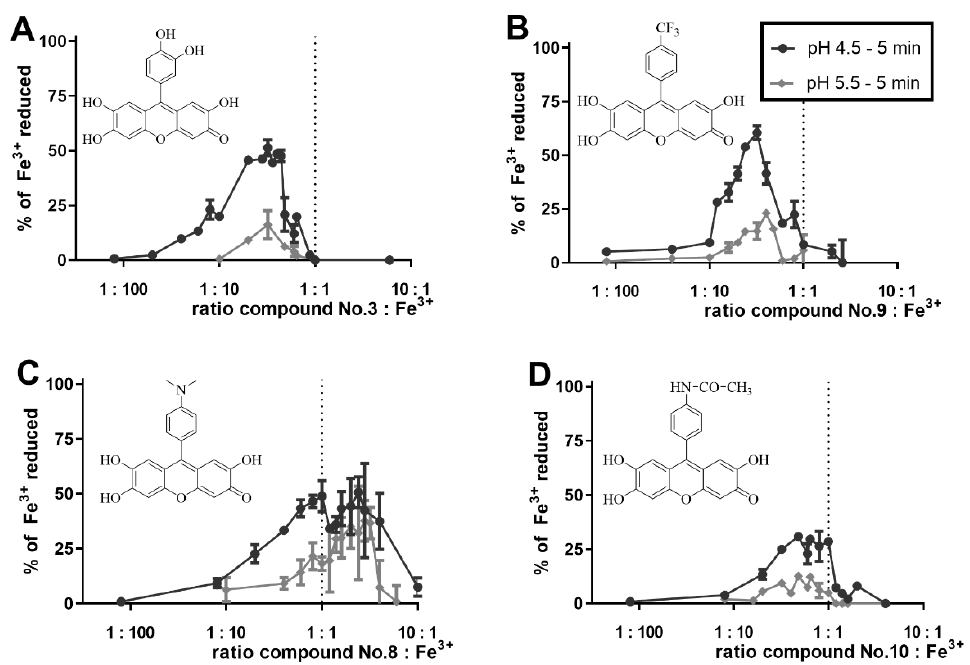
Figure 4. Iron reduction—representative compounds. A : 3′,4′-dihydroxy ( 3 ), B : 4′-trifluoromethyl ( 9 ), C : 4′-dimethylmino ( 8 ) and D : 4′-acetamido ( 10 ) derivatives. Results at higher pH (negligible reduction) are not shown. The final concentration of iron ions was 50 µM in all cases.